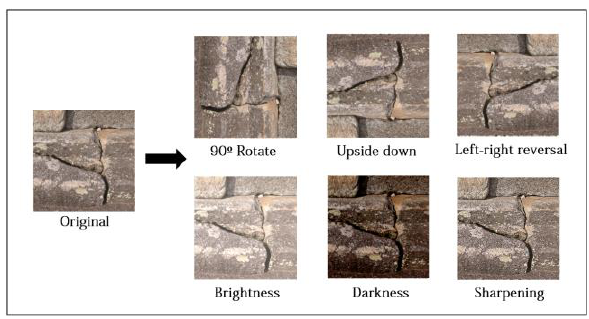
Figure 3. Augmentation training